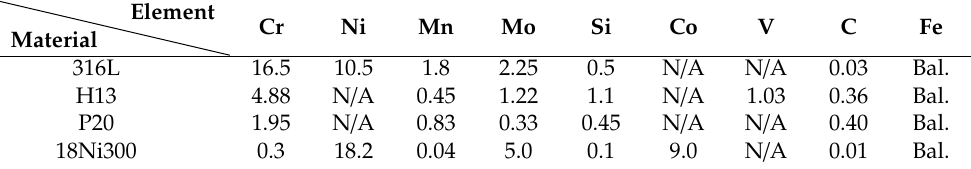
Table 1. Chemical composition (wt. %) of the four steel powders.